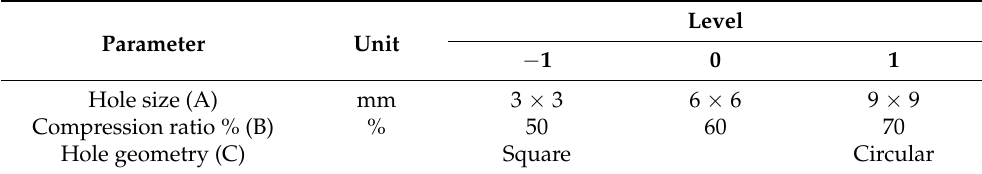
Table 1. Hole-type punch process parameters. Parameter Unit